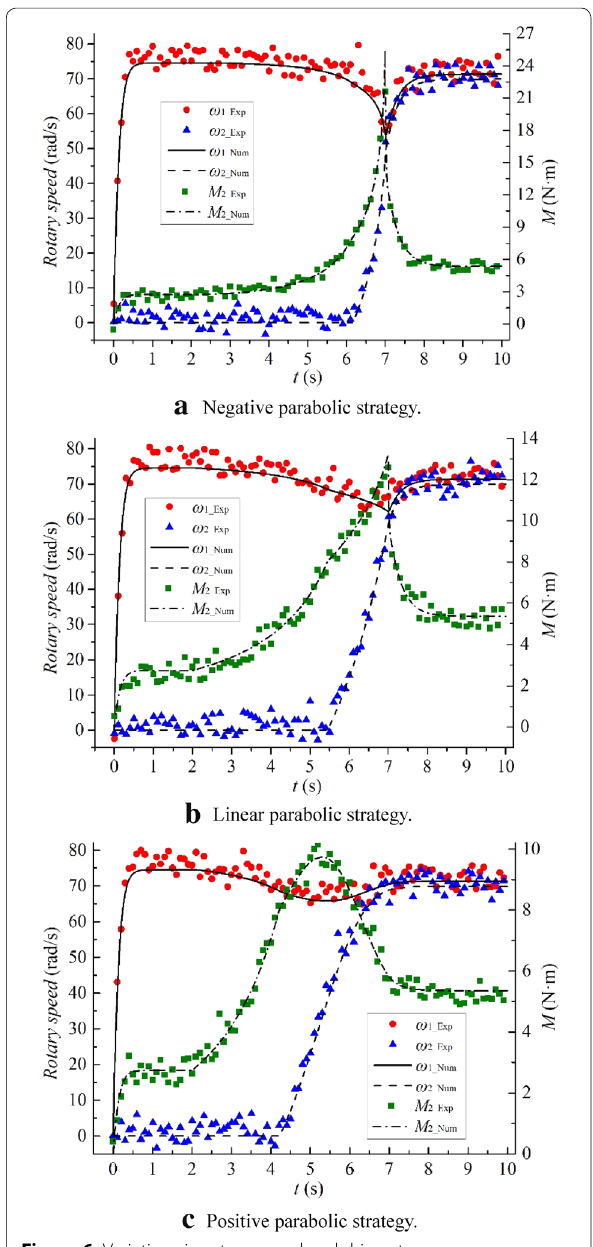
Figure 6 Variations in rotary speed and driven torque